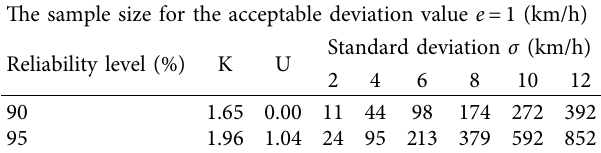
Table 4: Necessary and sufficient sample size. The sample size for the acceptable deviation value e � 1 (km/h)